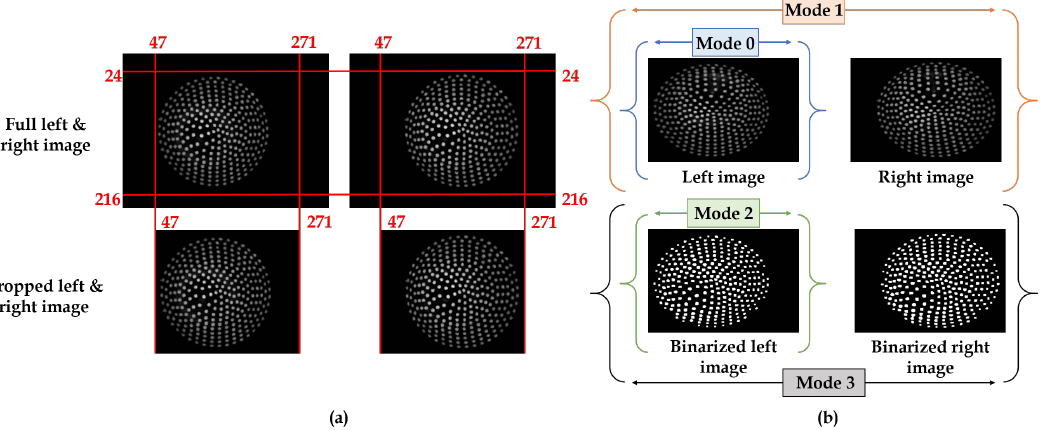
Figure 9. Pre-processing: ( a ) Cropping the input data through Region-of-Interest (ROI) setting for the stereo image pair. ( b ) Types of